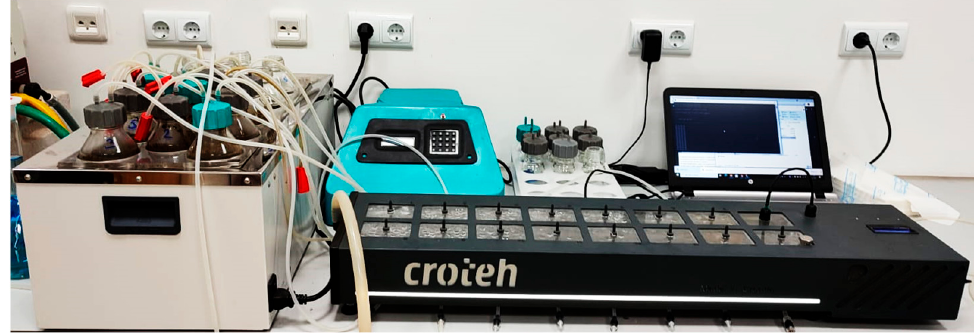
Figure 2. Anaerobic digestion experimental setup .